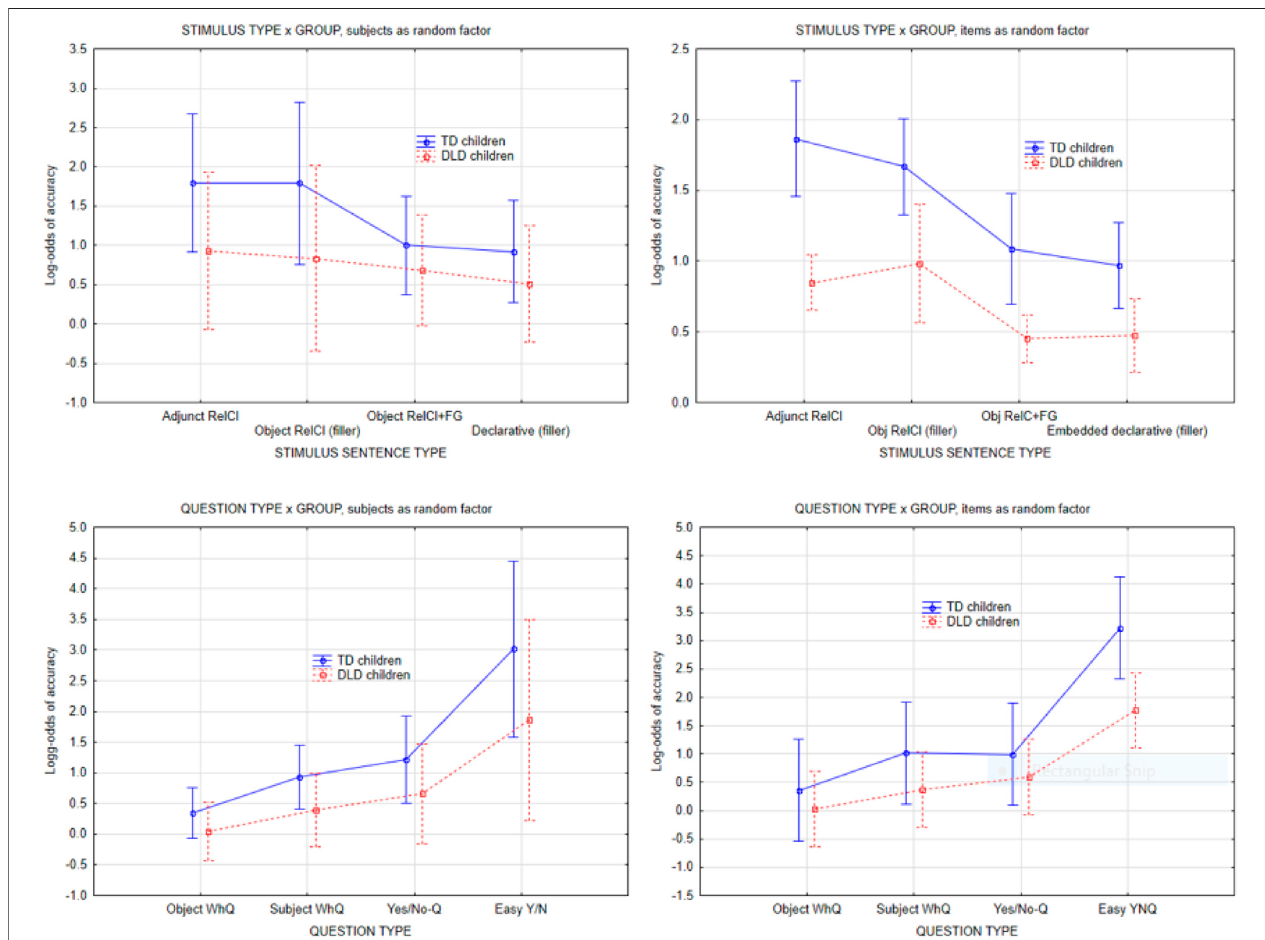
FIGURE 3 | Accuracy on comprehension questions by question type and stimulus sentence type, subject as random factor vs. item as random factor. Error bars indicate 95% con fi dence intervals.